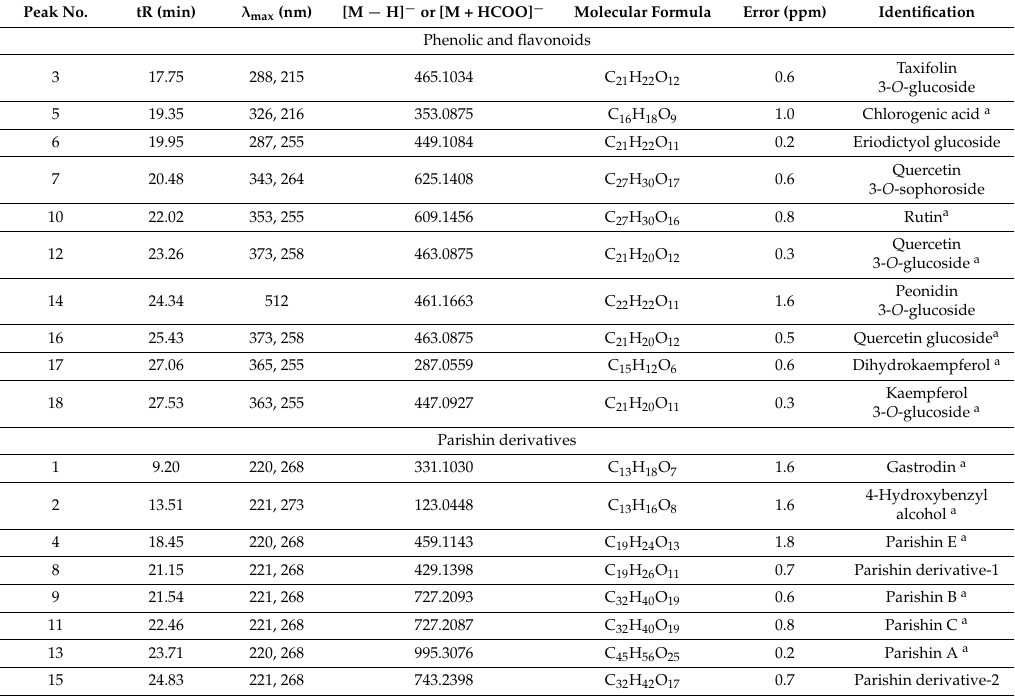
Table 1. Polyphenolic compounds identified in fully mature M. tricuspidata fruit by HPLC – QTOF MS. Peak No.